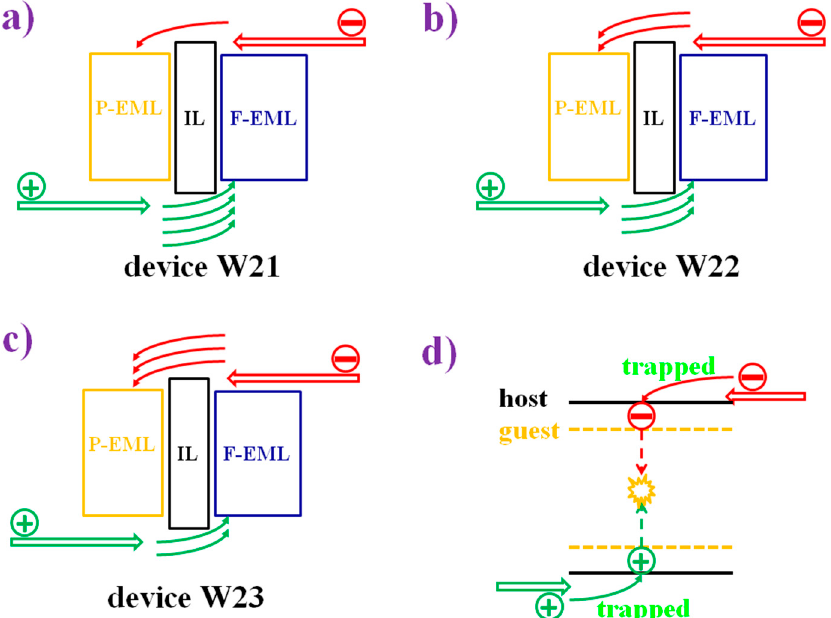
Figure 19. The WOLEDs’ function mechanism. IL is interlayer. F-EML is fluorescent EML. P-EML is phosphorescent EML. ( a ) TAPC:TmPyPB = 1:0; ( b ) TAPC:TmPyPB = 0.8:0.2; ( c ) TAPC:TmPyPB = 0.5:0.5; ( d ) Charge trapping effect of Ir(dmppy) 2 (dpp). Reproduced from Reference [193].